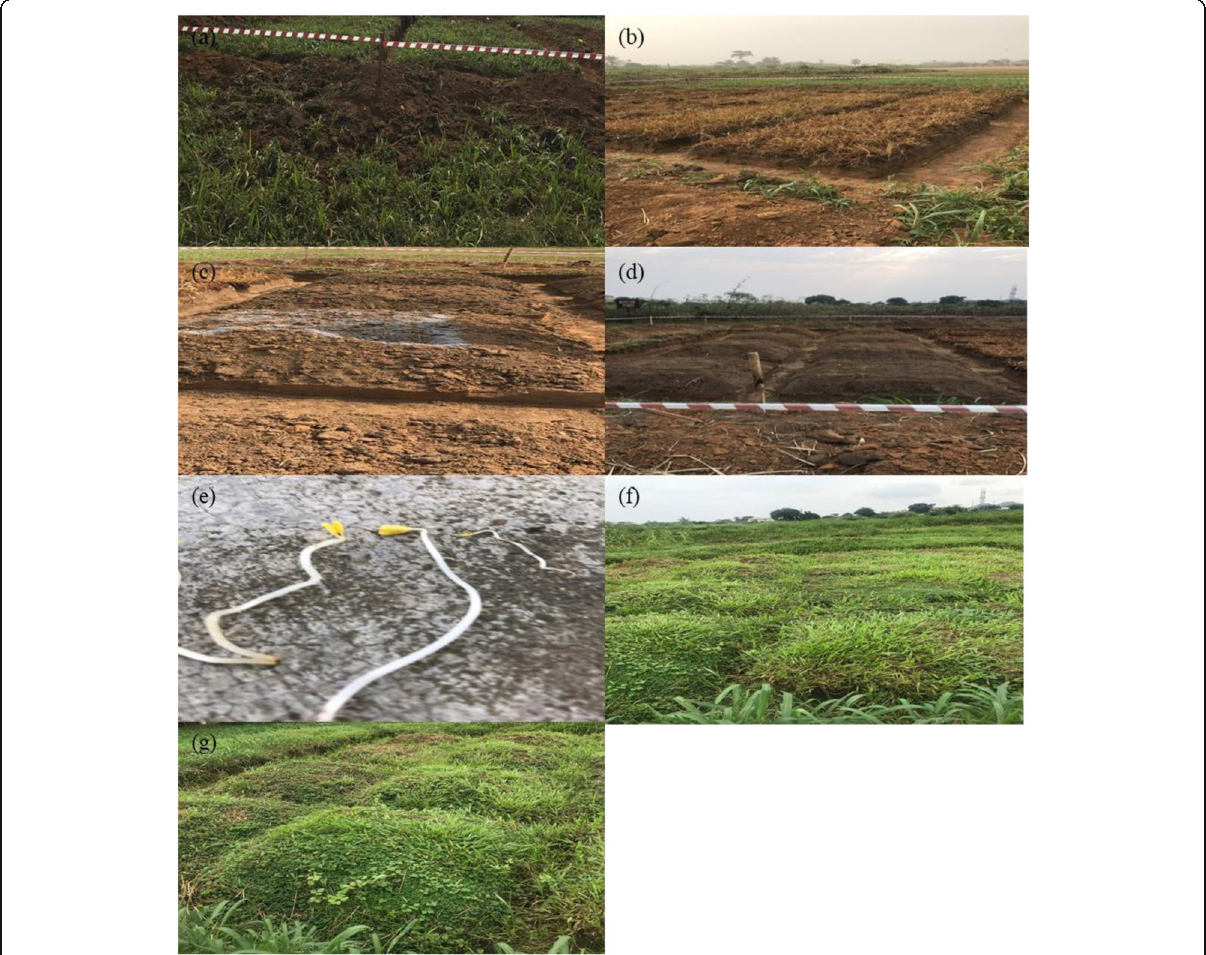
Fig. 7 Pictorial views of experimental site at various stages of treatment ( a ) Delineated portion contaminated with crude oil, ( b ) Crude oil contaminated soil with dead plants 2 weeks after contamination, ( c ) Remediation treatment with Bone Char/NPK, ( d ) 14 d after treatment, ( e ) 30 d after treatment with growths, ( f ) 45 d after treatment, ( g ) 60 d after